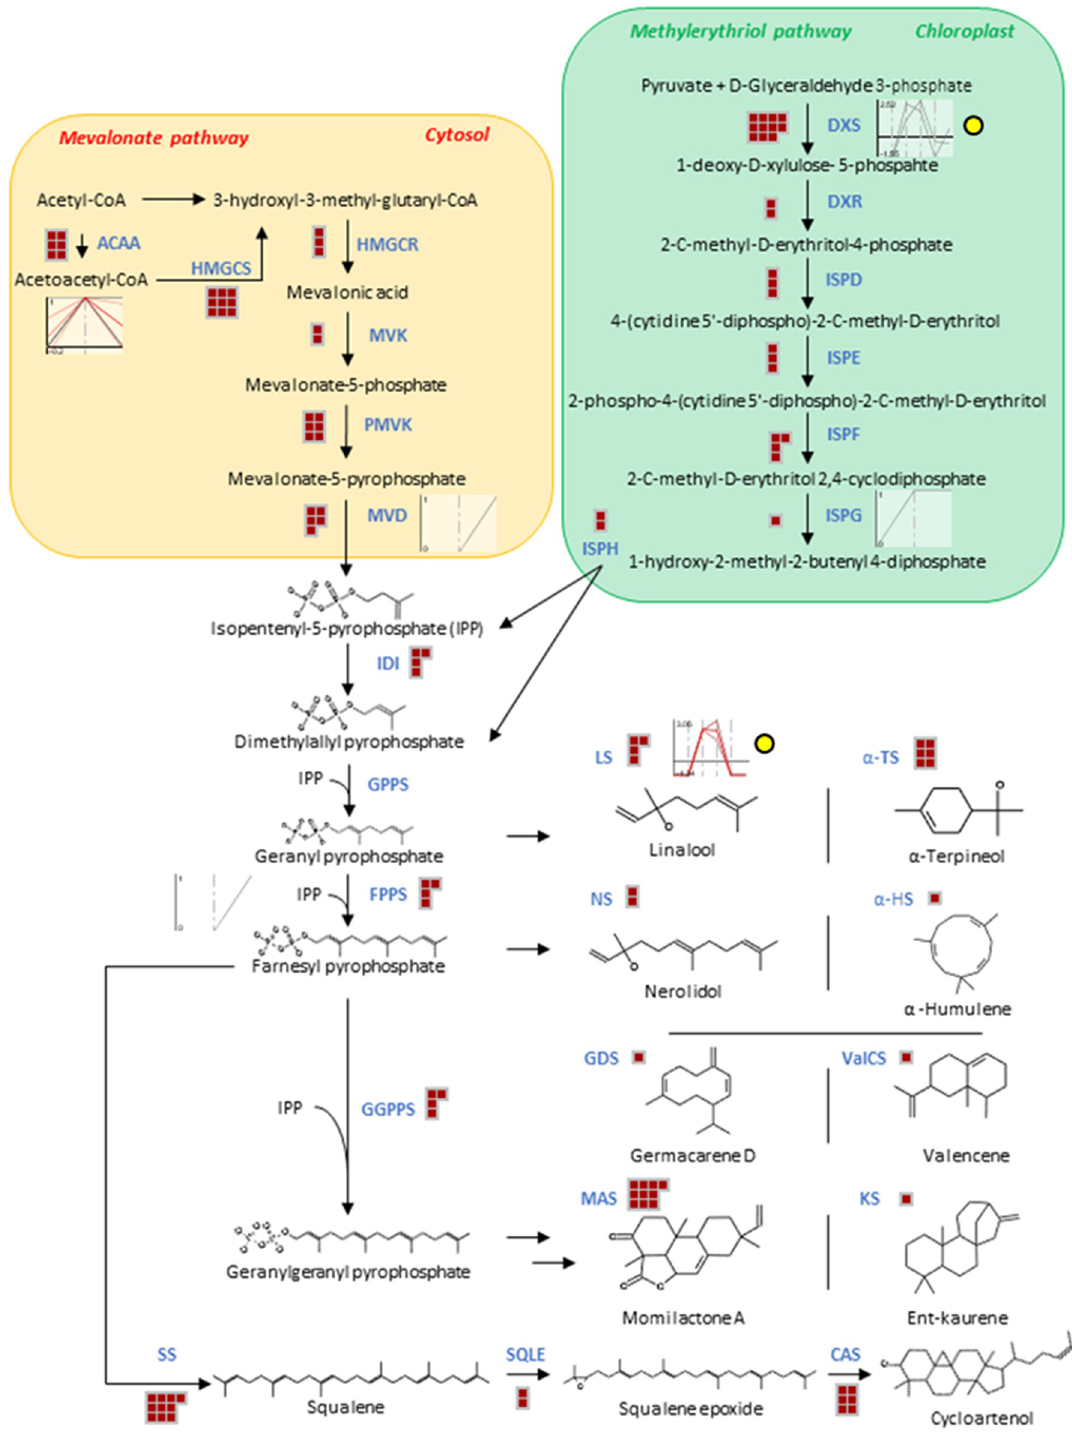
Fig 6. Terpene biosynthesis. Red squares indicate assembled transcripts. The 6-point line graphs with a yellow circle next to them are plots of differentially expressed transcripts in duplicate for the corm, leaf and flower tissues with log 2 (FPKM +1) on the vertical axis. The 3-point line graphs that are not otherwise marked, represent the qualitative detection of proteins in the corm, leaf and flower tissues.